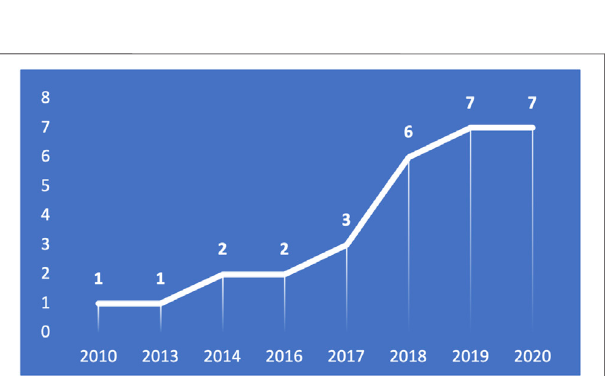
FIGURE 2 | The Preferred Reporting Items for Systematic Reviews and Meta-Analyses (PRISMA) chart.